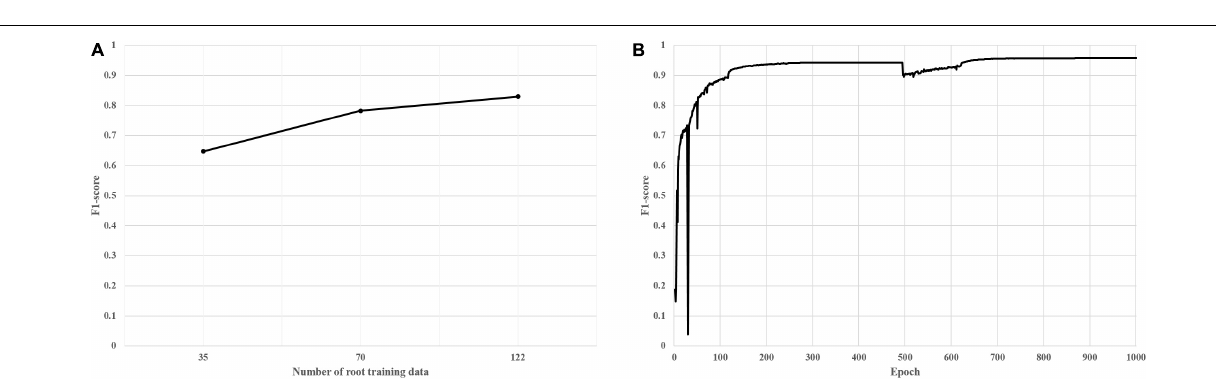
FIGURE 6 | F1-scores of trained deep segmentation networks; y -axis of 1.0 means 100 percentage matched between predicted mask image and actual mask image (ground truth image). (A) F1-scores of trained networks according to the number of training data (B) F1-scores of final deep segmentation network; an epoch means an iteration of the number of training